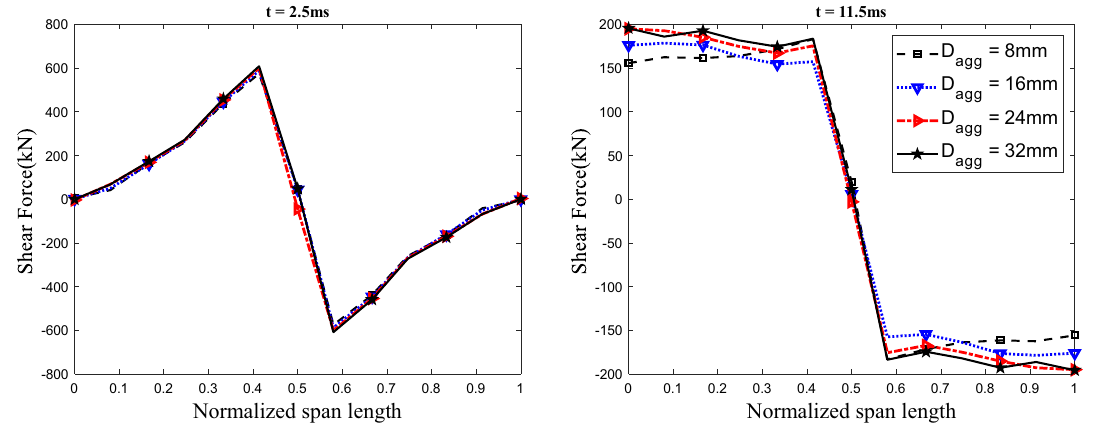
Fig. 22 Shear force diagram for CM1-S at 2.5 ms and 11.5